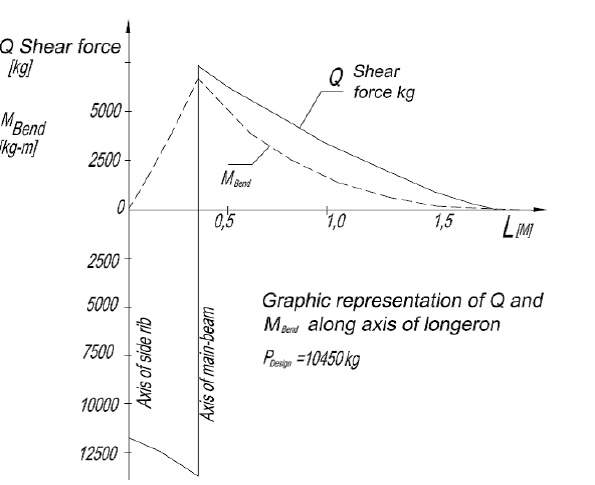
Figure 2: Bending Moment and Shear force